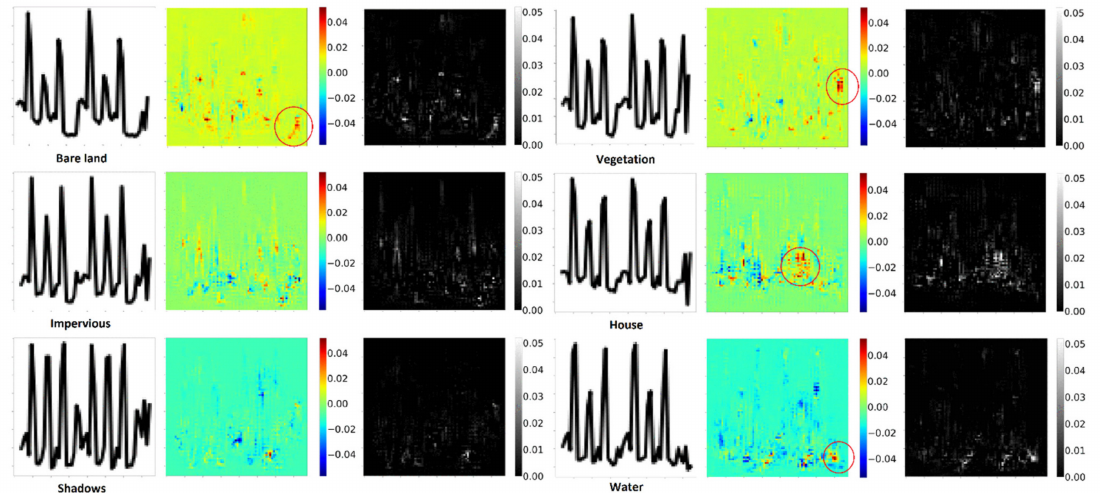
Figure 8. Salient maps of six classes using